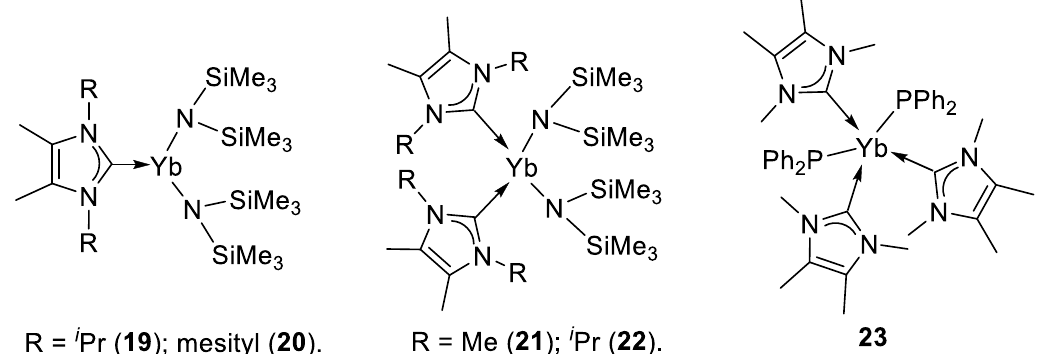
Figure 5. NHC-ligated Ln amides and phosphide used as catalysts for organic synthesis.